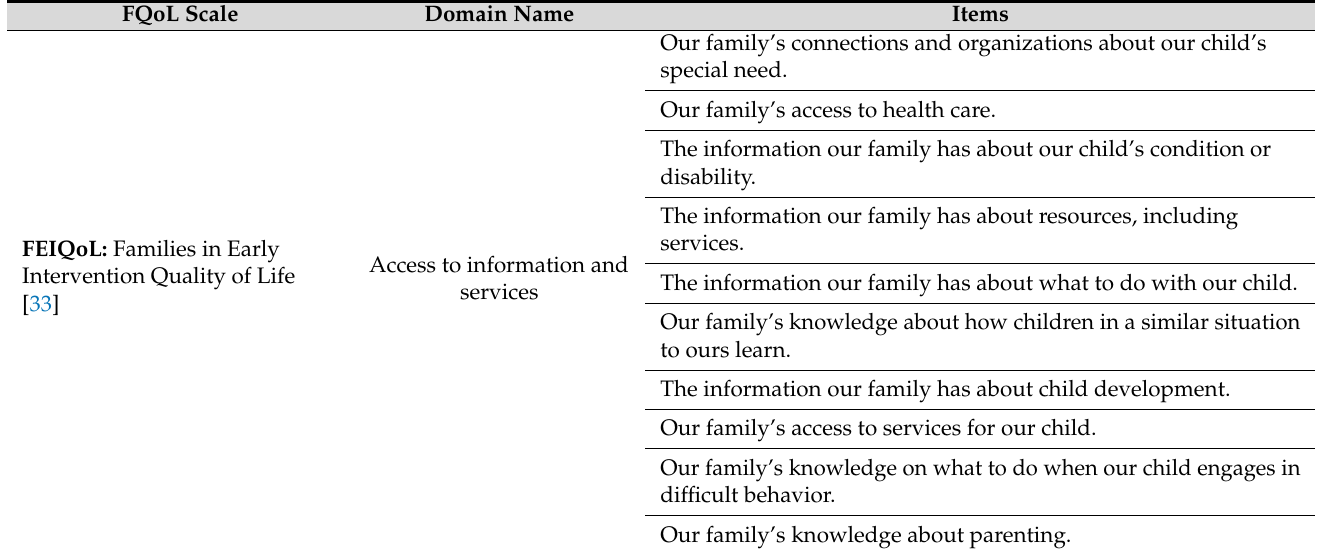
Table 12. Items considered in the domain of access to information and services within each respective FQoL scale.